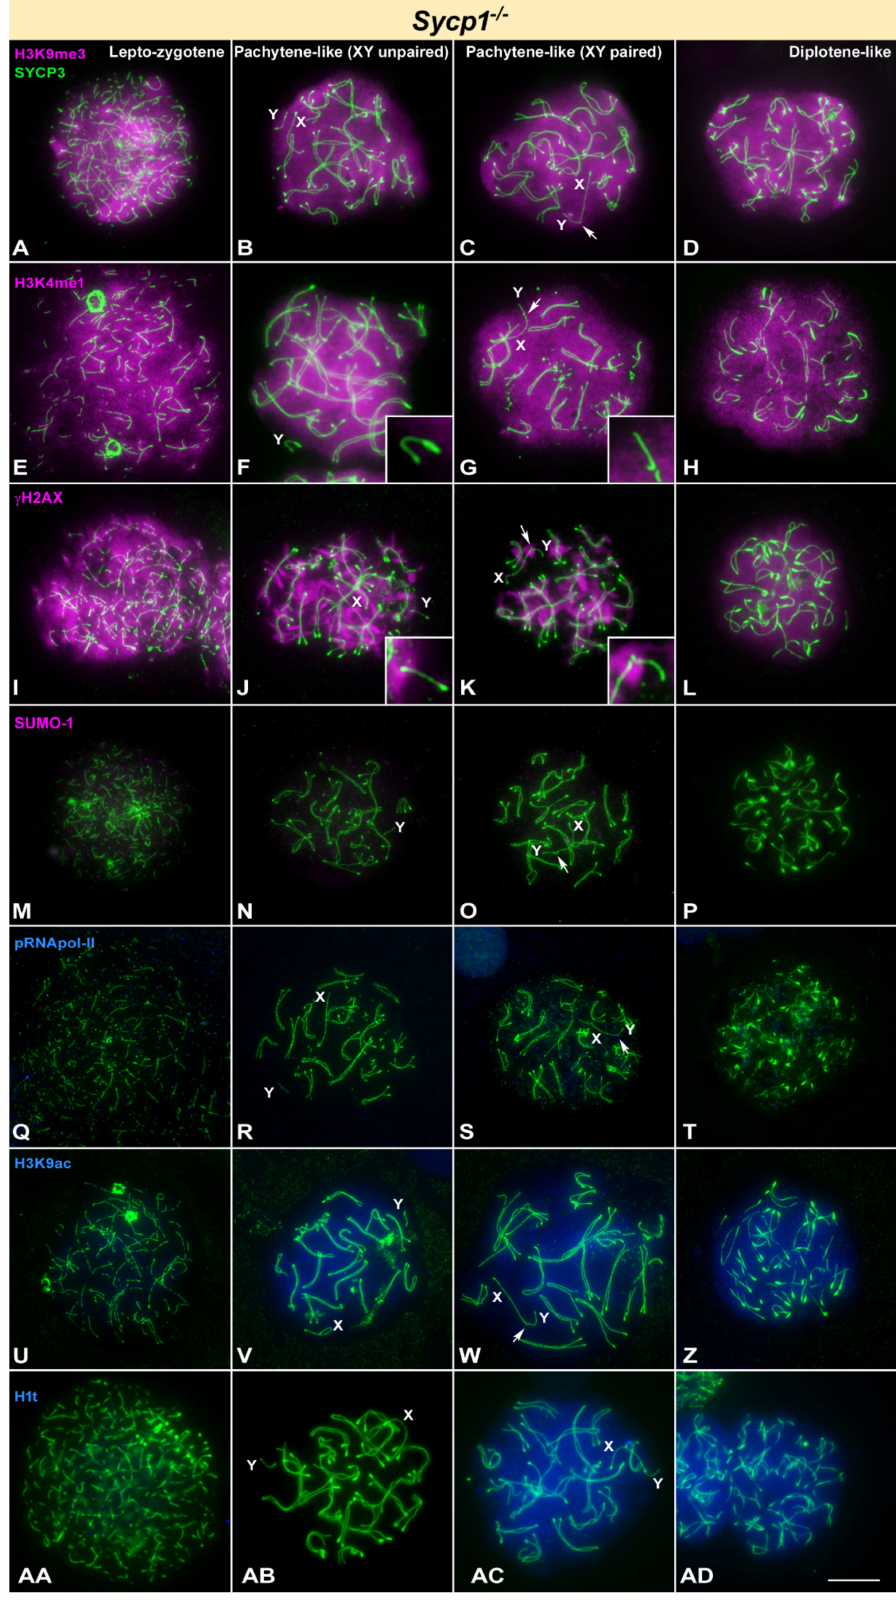
Figure 5. Immunolocalization of SYCP3 (green) and epigenetic markers of silencing (pink) or transcription activation (blue) in Sycp1 knockout mice. X and Y indicate the sex chromosomes, which are identified by their size and the morphology of the